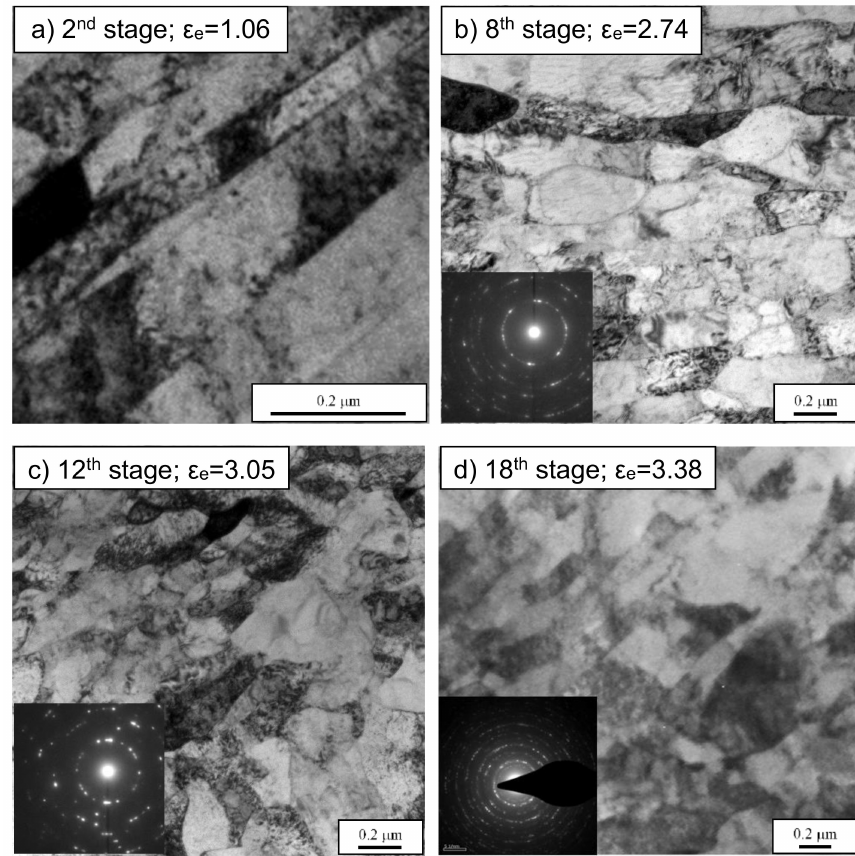
Figure 12. TEM micrograph and selected area electron di ff raction (SAED) patterns at axis c after several stages of the process. ( a ) 2nd stage, ε e = 1.06, ( b ) 8th stage, ε e = 2.74, ( c ) 12th stage, ε e = 3.05, ( d ) 18th stage, ε e =